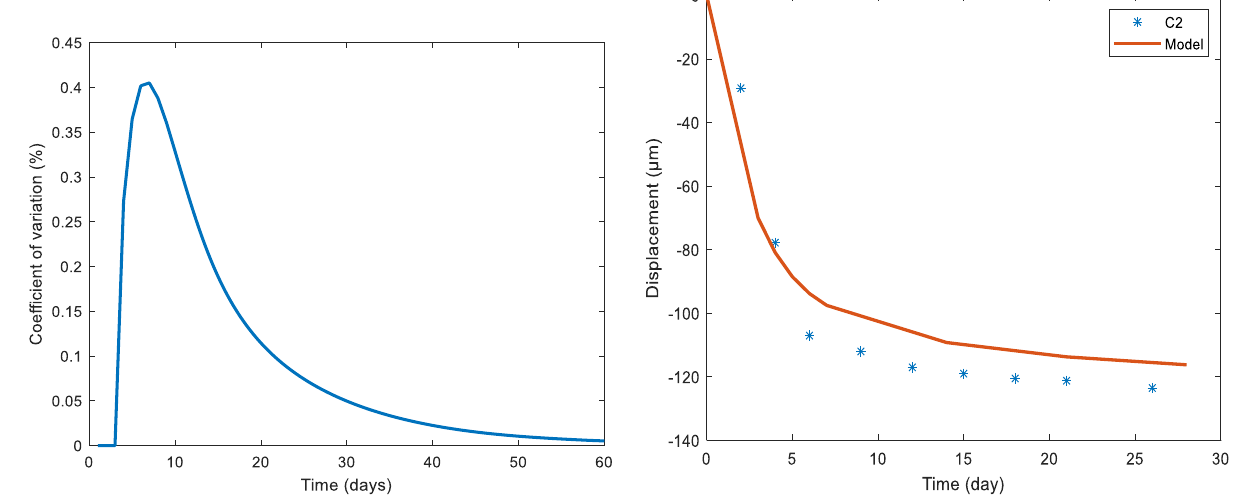
Figure 12: Young modulus coe ffi cient of variation. Figure 13: Midsurface